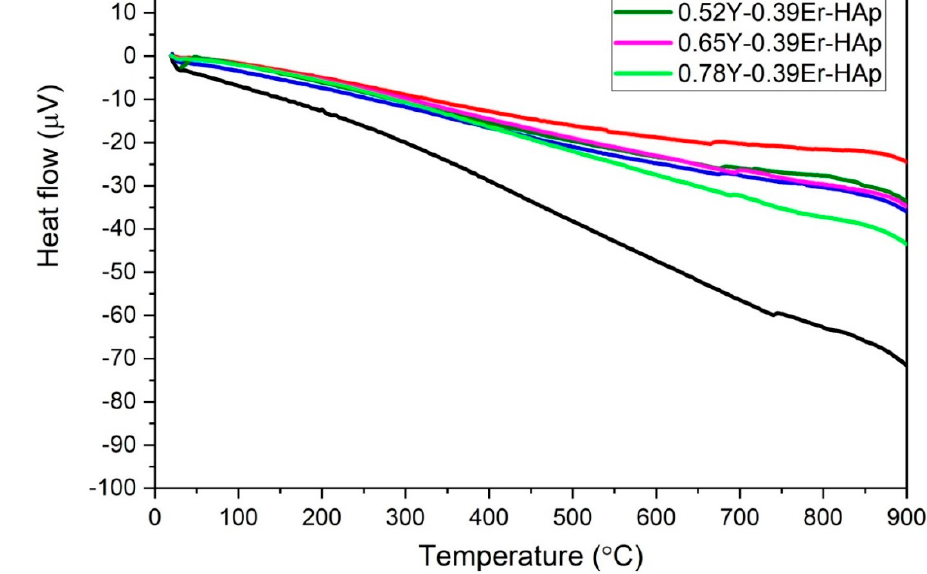
Figure 6. DTA thermograms.